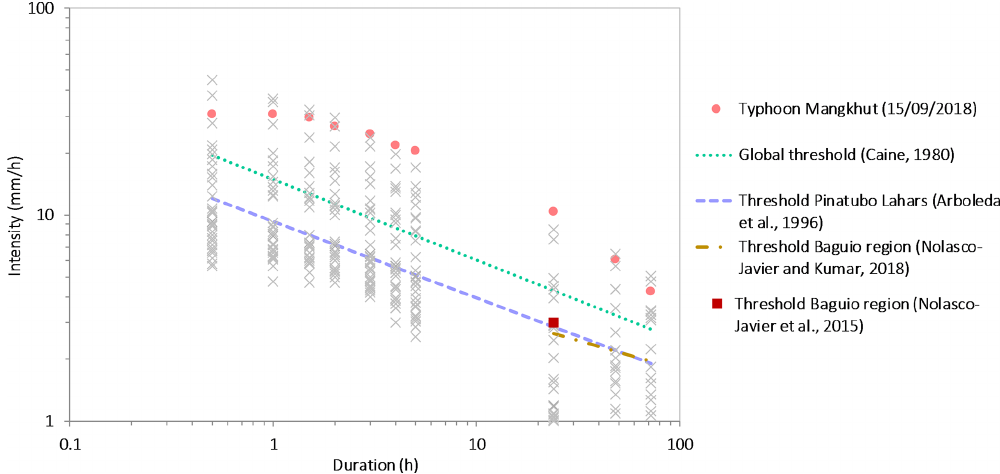
Figure 7. Intensity–duration correlations (using maximum floating intensities) of rainfall associated with Typhoon Mangkhut as well as 33 high-intensity rainfalls along 2018 in the study area. The rainfalls are compared to some global and regional thresholds published in the